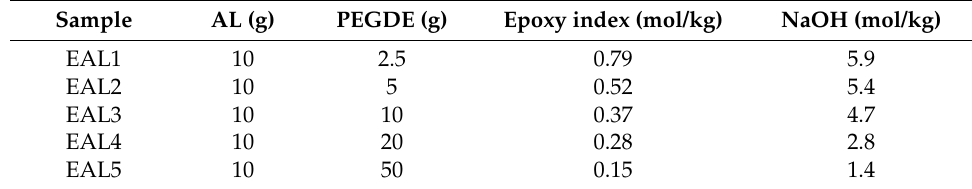
Table 1. Input PEGDE/AL ratios applied on lignin epoxidation reaction and corresponding epoxy index values and residual NaOH amounts